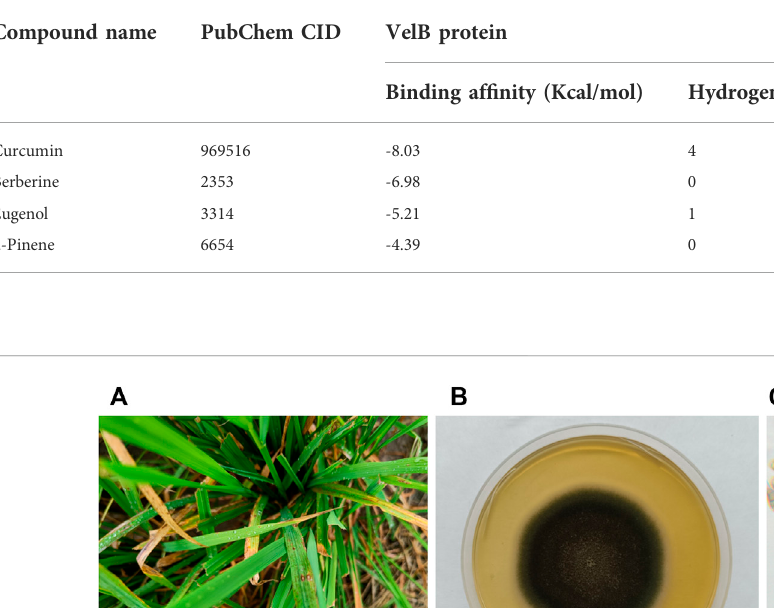
TABLE 3 Molecular docking af fi nity of four compounds with VelB protein of C. lunata